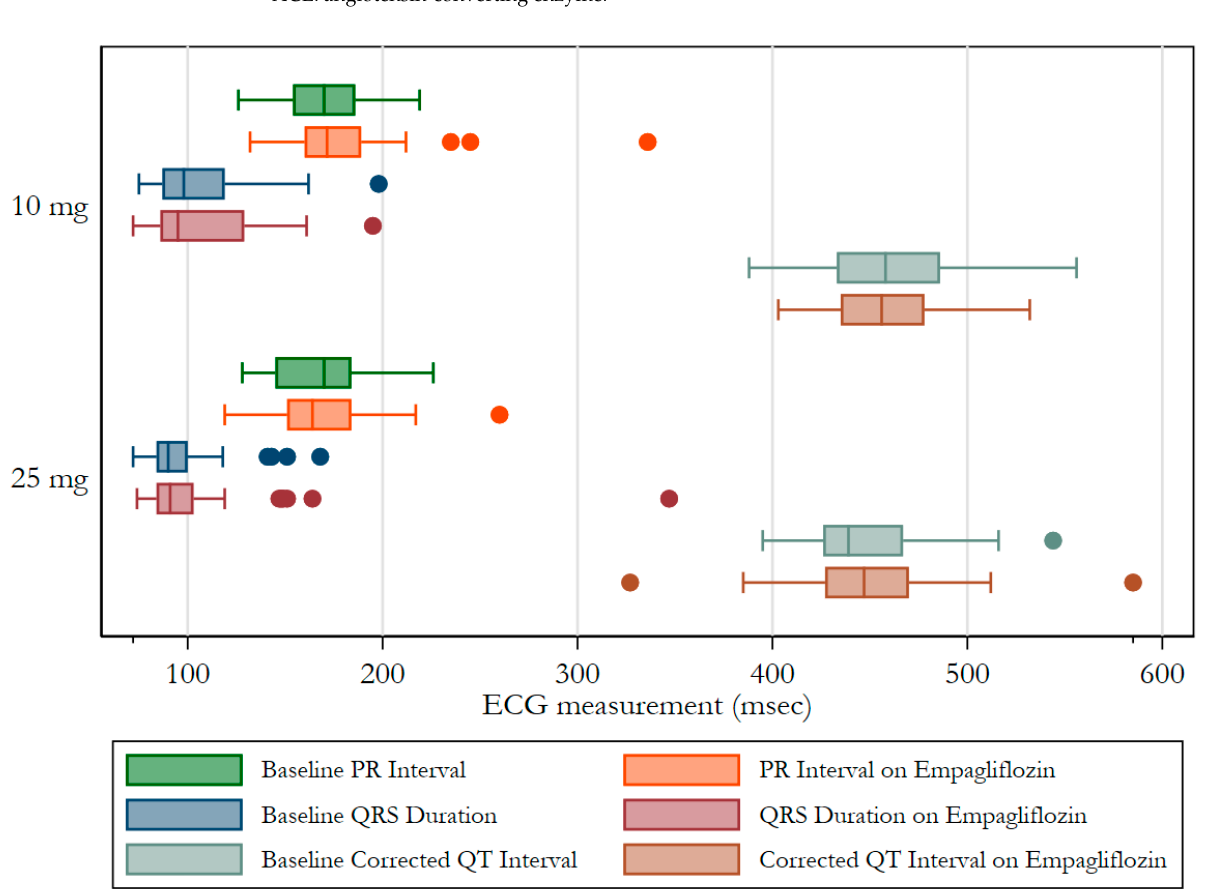
Figure 2. Comparison of ECG measurements before and after initiation of 10 mg versus 25 mg of empagliflozin. The colored circles indicate outliers.